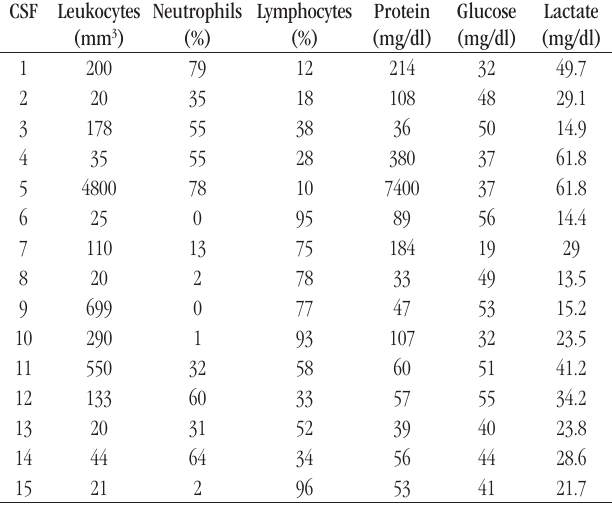
taBLE 1 − CSF findings in samples used for cytological stability assessment